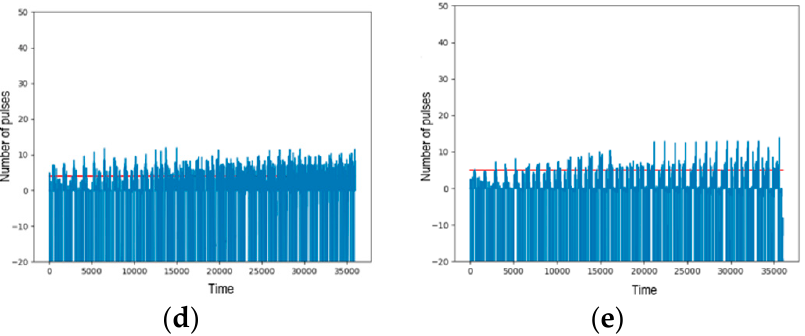
Figure 7. Comparison Chart of Pulse Threshold. ( a ) fixed high threshold; ( b ) fixed low threshold; ( c ) variable threshold for “1” with lateral suppression algorithm; ( d ) variable threshold for “2” without lateral suppression algorithm; ( e ) variable threshold for “2” with lateral suppression algorithm.